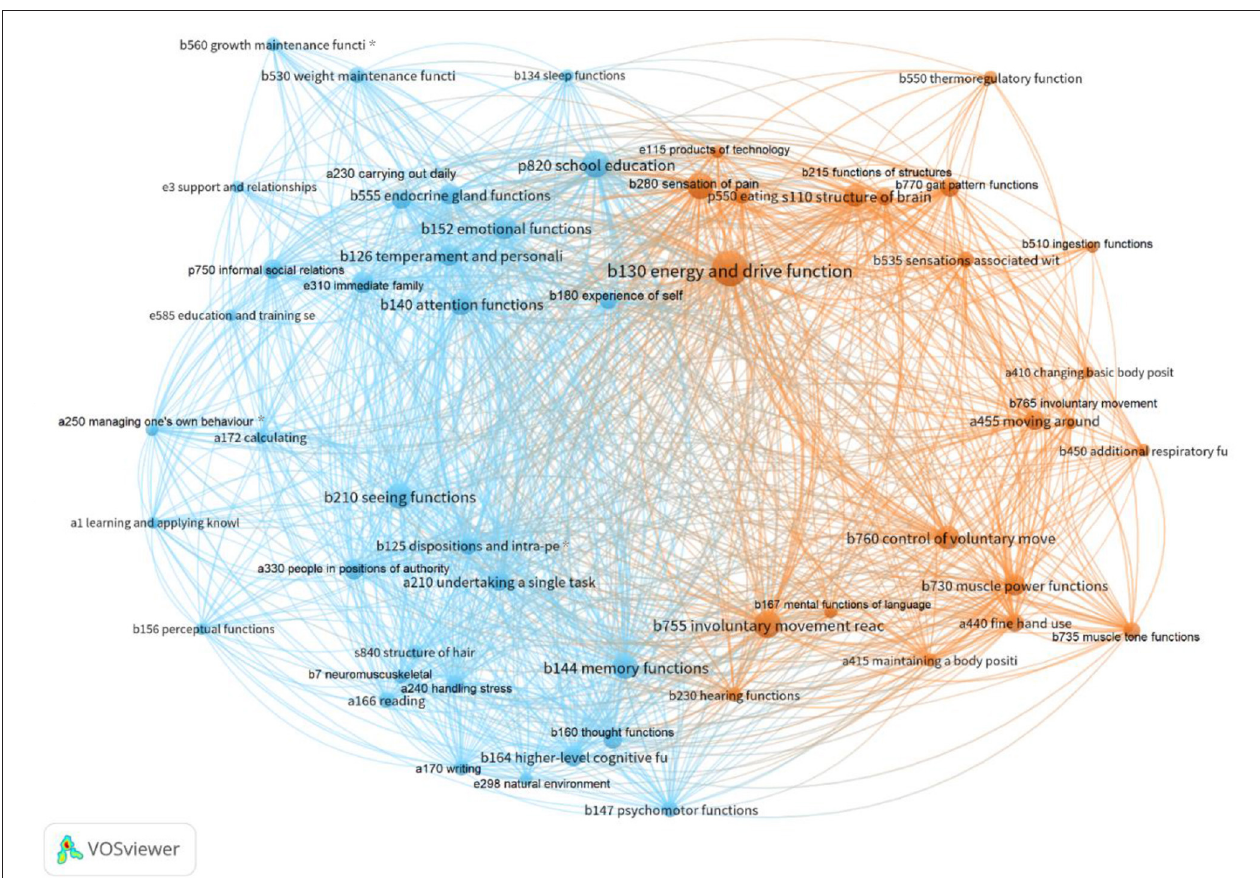
FIGURE 2 | Network visualization diagram within and between the ICF components. ICF- codes with labels (shortened), co-occurrence threshold = least 10 occurrences, No. of codes = 54, No. of clusters = 2. Blue cluster codes; b134 sleep functions, b125 dispositions and intra-personal functions*, b126 temperament and personality functions, b140 attention functions, b144 memory functions, b152 emotional functions, b180 experience of self and time functions, b210 seeing functions, b530 weight maintenance functions, b560 growth maintenance functions*, b730 muscle power functions, b750 motor reflex functions, b760 control of voluntary movement functions, a166 reading, a170 writing, a172 calculating, a210 undertaking a single task, a240 handling stress and other psychological demands, a250 managing one’s own behavior*, a330 Speaking, a350 conversation, p750 informal social relationships, p820 school education, e250 sound, e298 natural environment and human-made changes to environment, other specified, e310 immediate family, e330 people in positions of authority, e585 education and training services, systems, and policies. Orange cluster codes; b130 energy and drive functions, b230 hearing functions, b280 sensation of pain, b510 ingestion functions, b535 sensations associated with the digestive system, b550 thermoregulatory functions, b730 muscle power functions, b735 muscle tone functions, b755 involuntary movement reaction functions, b760 control of voluntary movement functions, b770 gait pattern functions, a410 changing basic body position, a415 maintaining